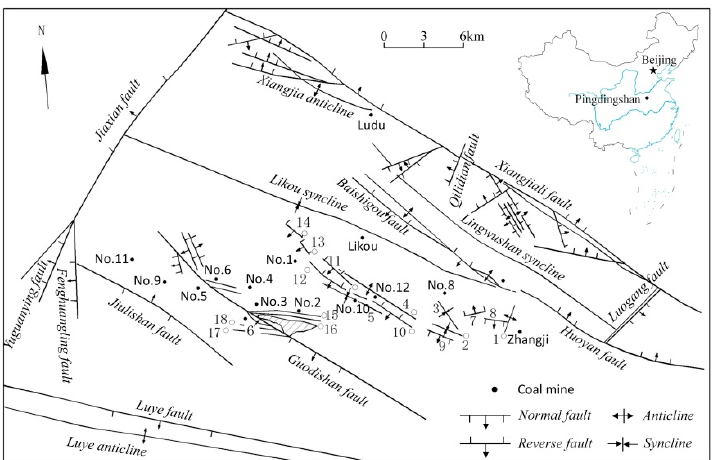
Figure 6. Regional geological structure and mining distributions of the PDS coalfield (1. Qiannie